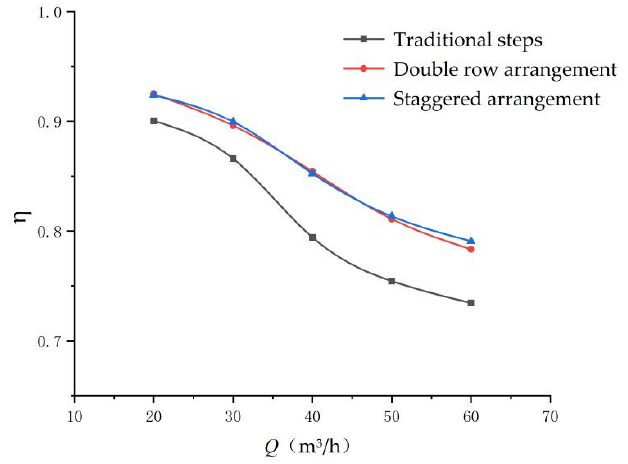
Figure 13. Energy dissipation rate of each body type step